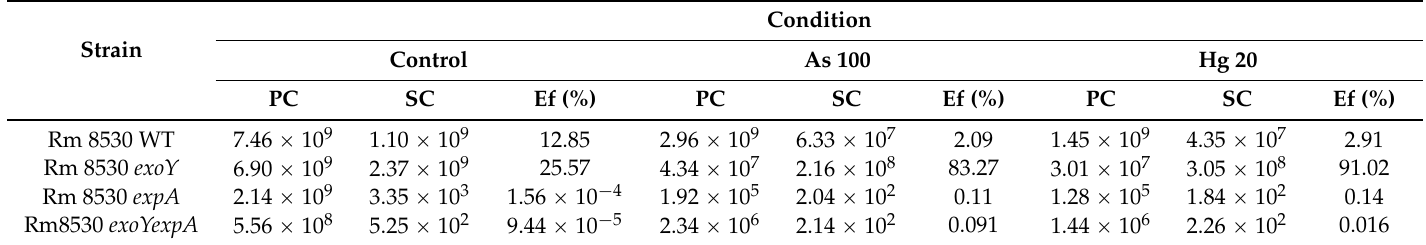
Table 2. Planktonic and sessile cell count of S. meliloti strains on TY medium with different metals.